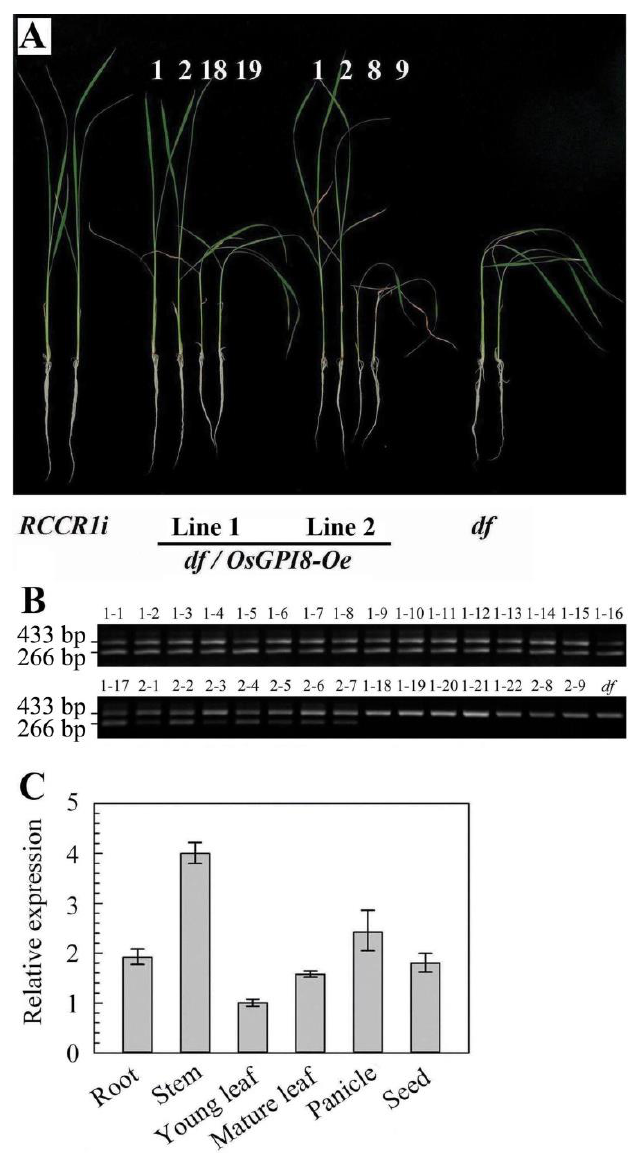
Figure 5. Complementation of the df mutant by the OsGPI8 gene. ( A ) Two-week-old seedlings of two representative T2 lines of df plants overexpressing OsGPI8 ( df / OsGPI8-Oe ) grown under 29–33 °C conditions. Phenotype segregation (the ratio of normal phenotype to df phenotype is 17:5 and 7:2, in two independent lines, respectively) was observed among two independent df / OsGPI8-Oe T2 families. ( B ) Genomic PCR analysis of df / OsGPI8-Oe T2 families. The 433 bp bands are products amplified from the rice genomic DNA of the OsGPI8 gene, while the 266 bp bands are products from the artificial OsGPI8 gene (which contains no intron). The 266 bp bands are absent in these plants. The binding sites for the primer pair are indicated in Figure 2B. ( C ) Analysis of expression of the OsGPI8 gene. Each PCR assay was run in duplicate for three independent biological repeats. The comparative